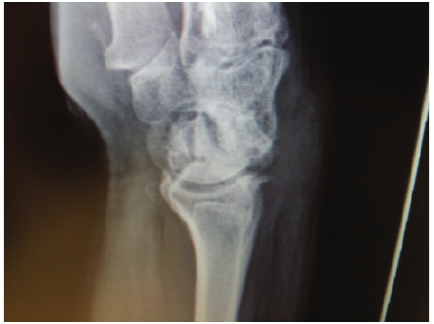
Figure 5: Postdistraction radiograph showing improved radio- carpal joint line.